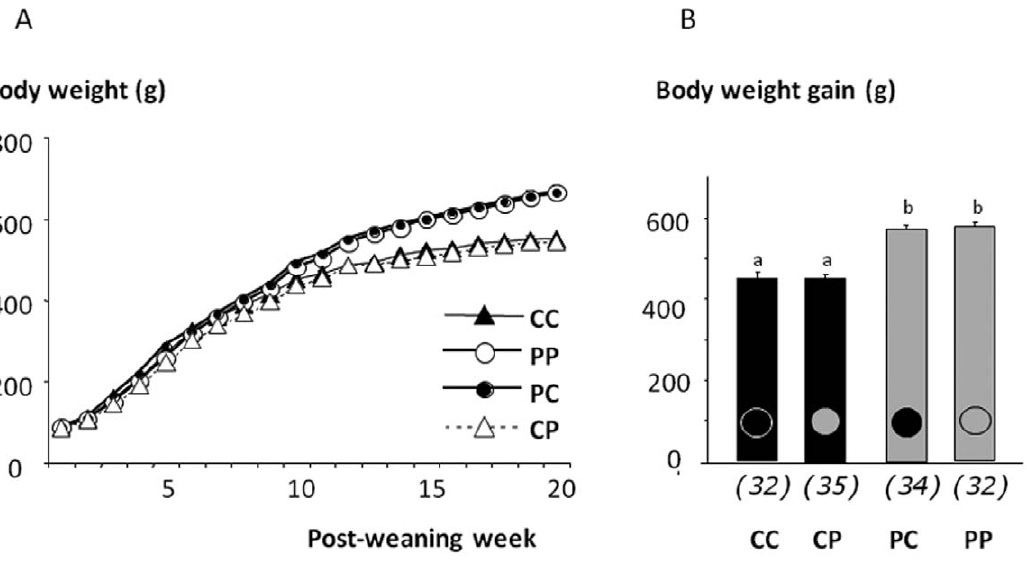
Figure 3. Impact of post weaning diet on the body weight of male pups born to dams fed the control diet (C) or highly palatable diet (P). At weaning four groups of male pups (CC, n=32; CP, n=35; PC, n=34; PP, n=32) were formed and named according to the post weaning diet (C or P, first letter) and to maternal diet (C or P, second letter) and their body weight and body weight gain were registred during 20 weeks after weaning. Body weight and final body weight gain are reported in panel 3A and 3B, respectively (*p , 0.05).